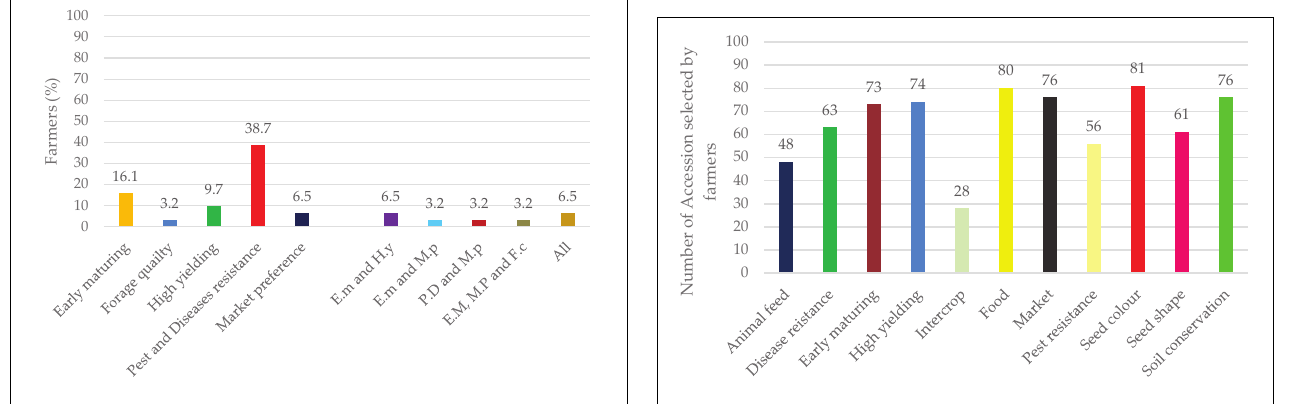
FIGURE 11 | Farmers’ preferred traits for variety development. FIGURE 12 | Preferred trait selection by